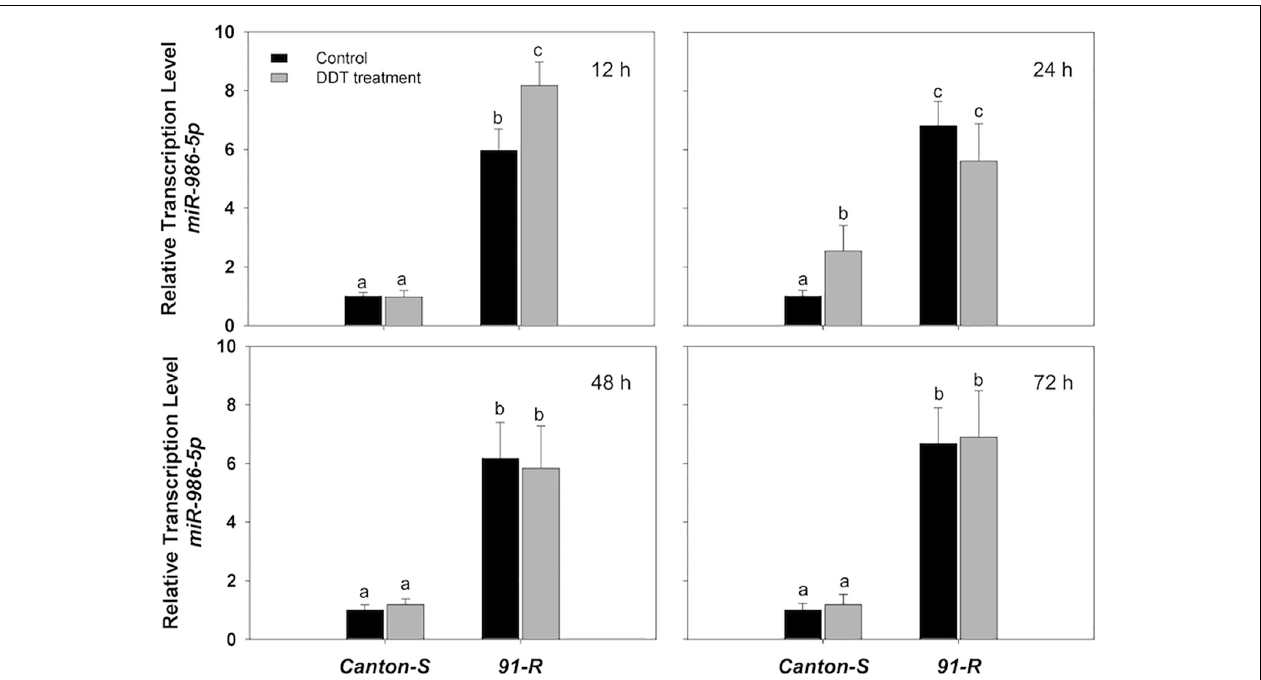
FIGURE 2 | The expression of miR-986-5p in DDT-resistant 91-R and the DDT-susceptible Canton-S strains following DDT exposure. The induction or repression level of expression were analyzed 12, 24, 48, and 72 h after DDT exposure. The relative levels of gene expression shown along the Y axis represent the ratio of the gene expression in each treatment compared to the acetone-treated Canton-S strain. The experiments were repeated three times. The vertical bars indicate SEM. Different letters on the bars indicate that the means are significantly different throughout the strains where the P -value < 0.05.